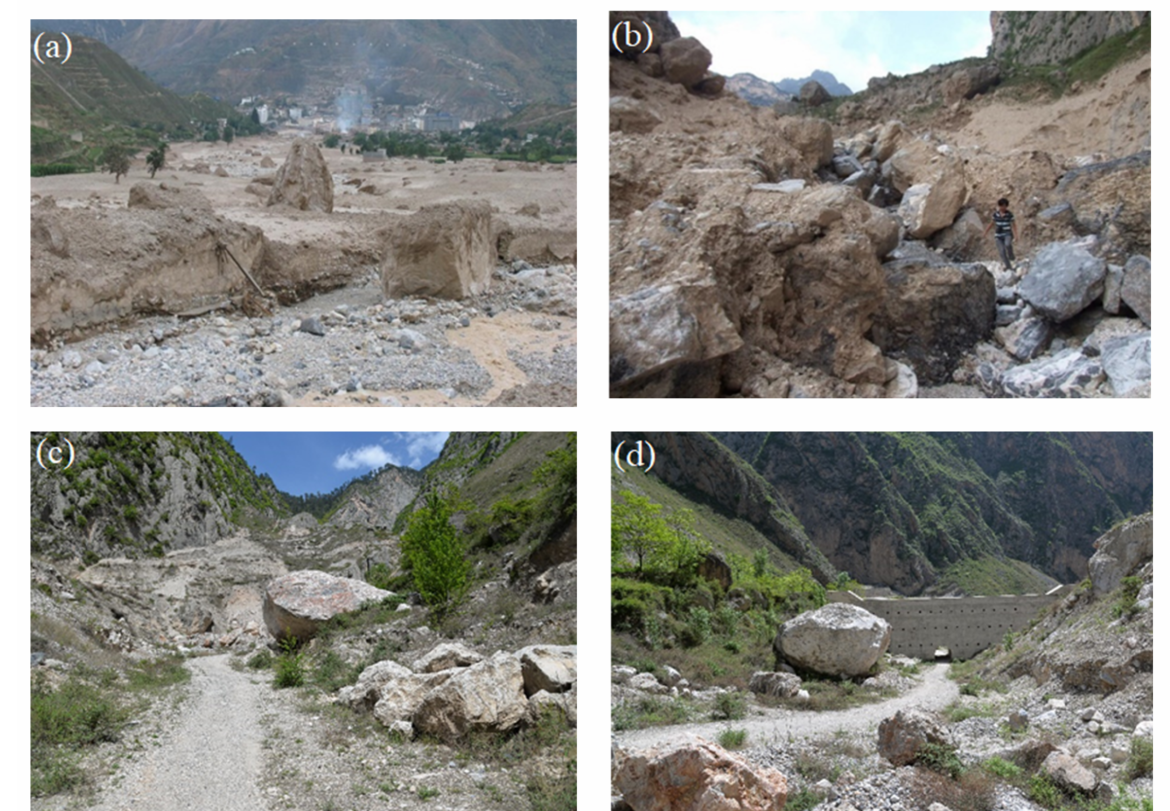
Figure 2. Picture of the Zhouqu debris flow: ( a ) boulders left in the accumulation area after the Zhouqu debris flow, ( b , c ) boulders in the gully, and ( d ) a boulder approximately 18 m in diameter upstream of a check